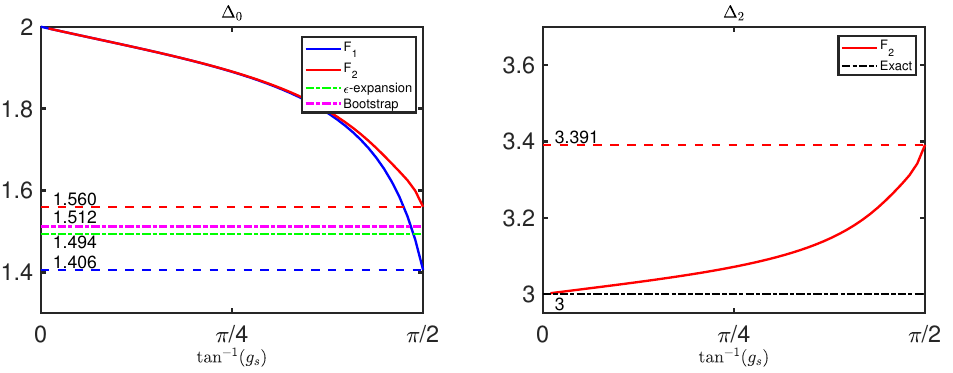
Figure 10 . Extrapolations of the scaling dimensions from the Dirac fermion point (tan (cid:0) 1 ( g to the O (2) point (tan (cid:0) 1 ( g s ) = (cid:25)=